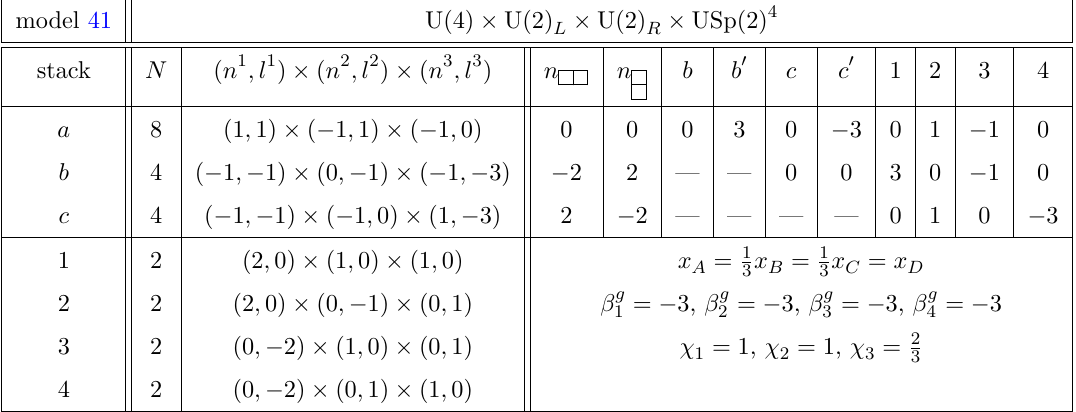
Table 41 . D6-brane configurations and intersection numbers of Model 41, and its MSSM gauge